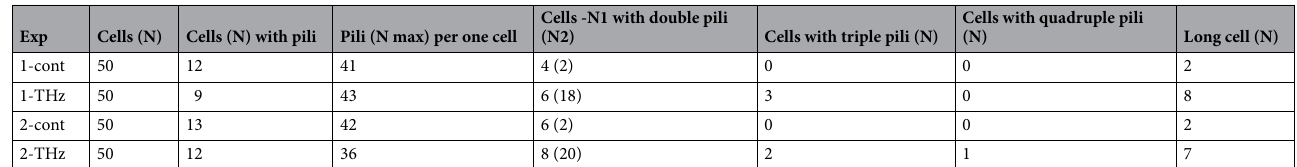
Table 2. Influence of THz irradiation on the numerical characteristics of an E. coli cell population. Determination of the number of bacterial cells with pili, the total number of pili per cell, the number of bacteria with clumped pili (two-pilus, three-pilus, and four-pilus bundles), as well as the number of elongated (more than 5 μm) bacterial cells was performed on 50 E. coli cells randomly selected from each of the following four groups: 1-cont and 2-cont, nonirradiated cells; 1-THz and 2-THz, irradiated cells. The analysis was carried out by means of an electron microscope on preparations obtained by the negative contrast method. N the number of counted cells and pili.